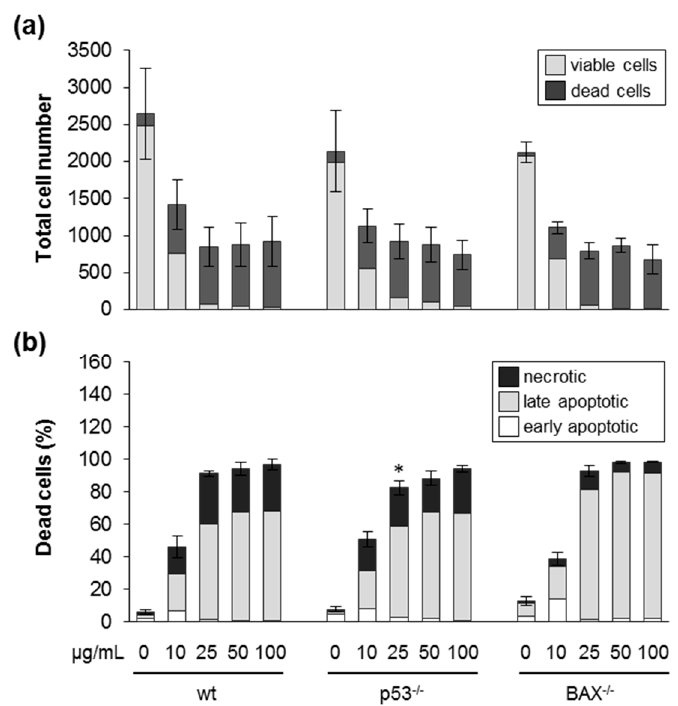
Figure 5. Silica NPs induce cell death independent of p53 and BAX. HCT116 wild-type (wt), p53 knock-out ( − / − ) and BAX knock-out ( − / − ) cells were incubated with SiO 2 —12 nm NPs as indicated in the absence of FBS. After 24 h, the cells were processed and analyzed as described in Figure 2. ( a ) The total cell number divided into living and dead cells. ( b ) The percentage of dead cells relative to the total cell number divided into the di ff erent classes of cell death as indicated. Data show mean values of five–six independent experiments with wt and p53 − / − cells. For BAX − / − cells, one representative experiment out of two is shown. All experiments were carried out with three–four replicates. The error bars are SD values related to the total cell number ( a ) or the percentage of total dead cells ( b ), respectively. Note that there was no major di ff erence in the response of p53 − / − or BAX − / − compared to wild-type cells. * p < 0.05.